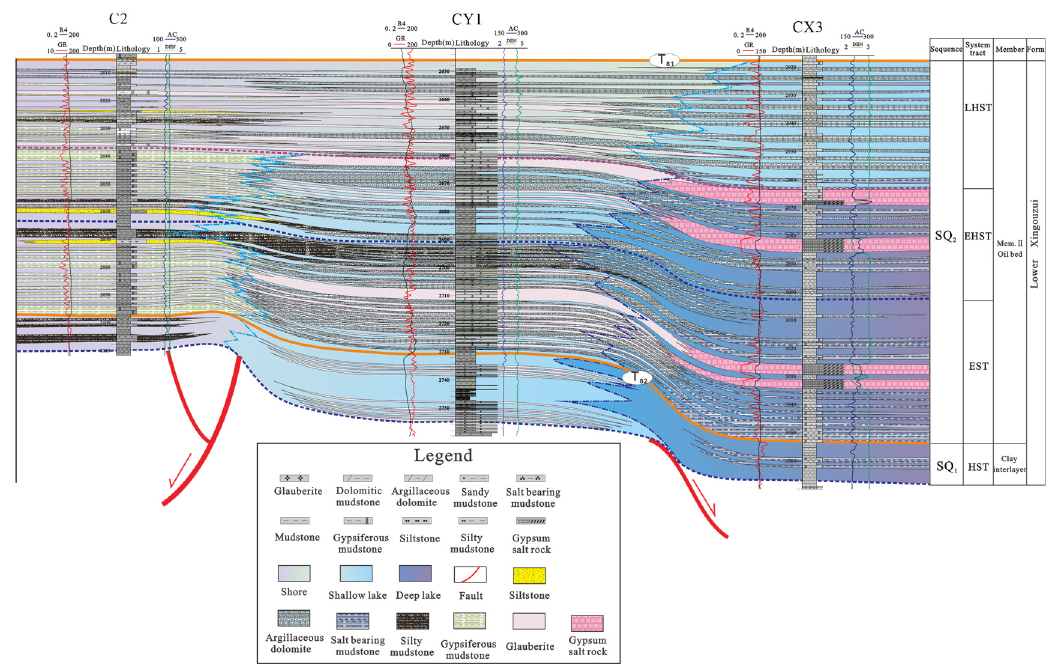
Figure 8. Cross well of C2-CY1-CX3 in Chentuokou Depression location see in Figure 2.